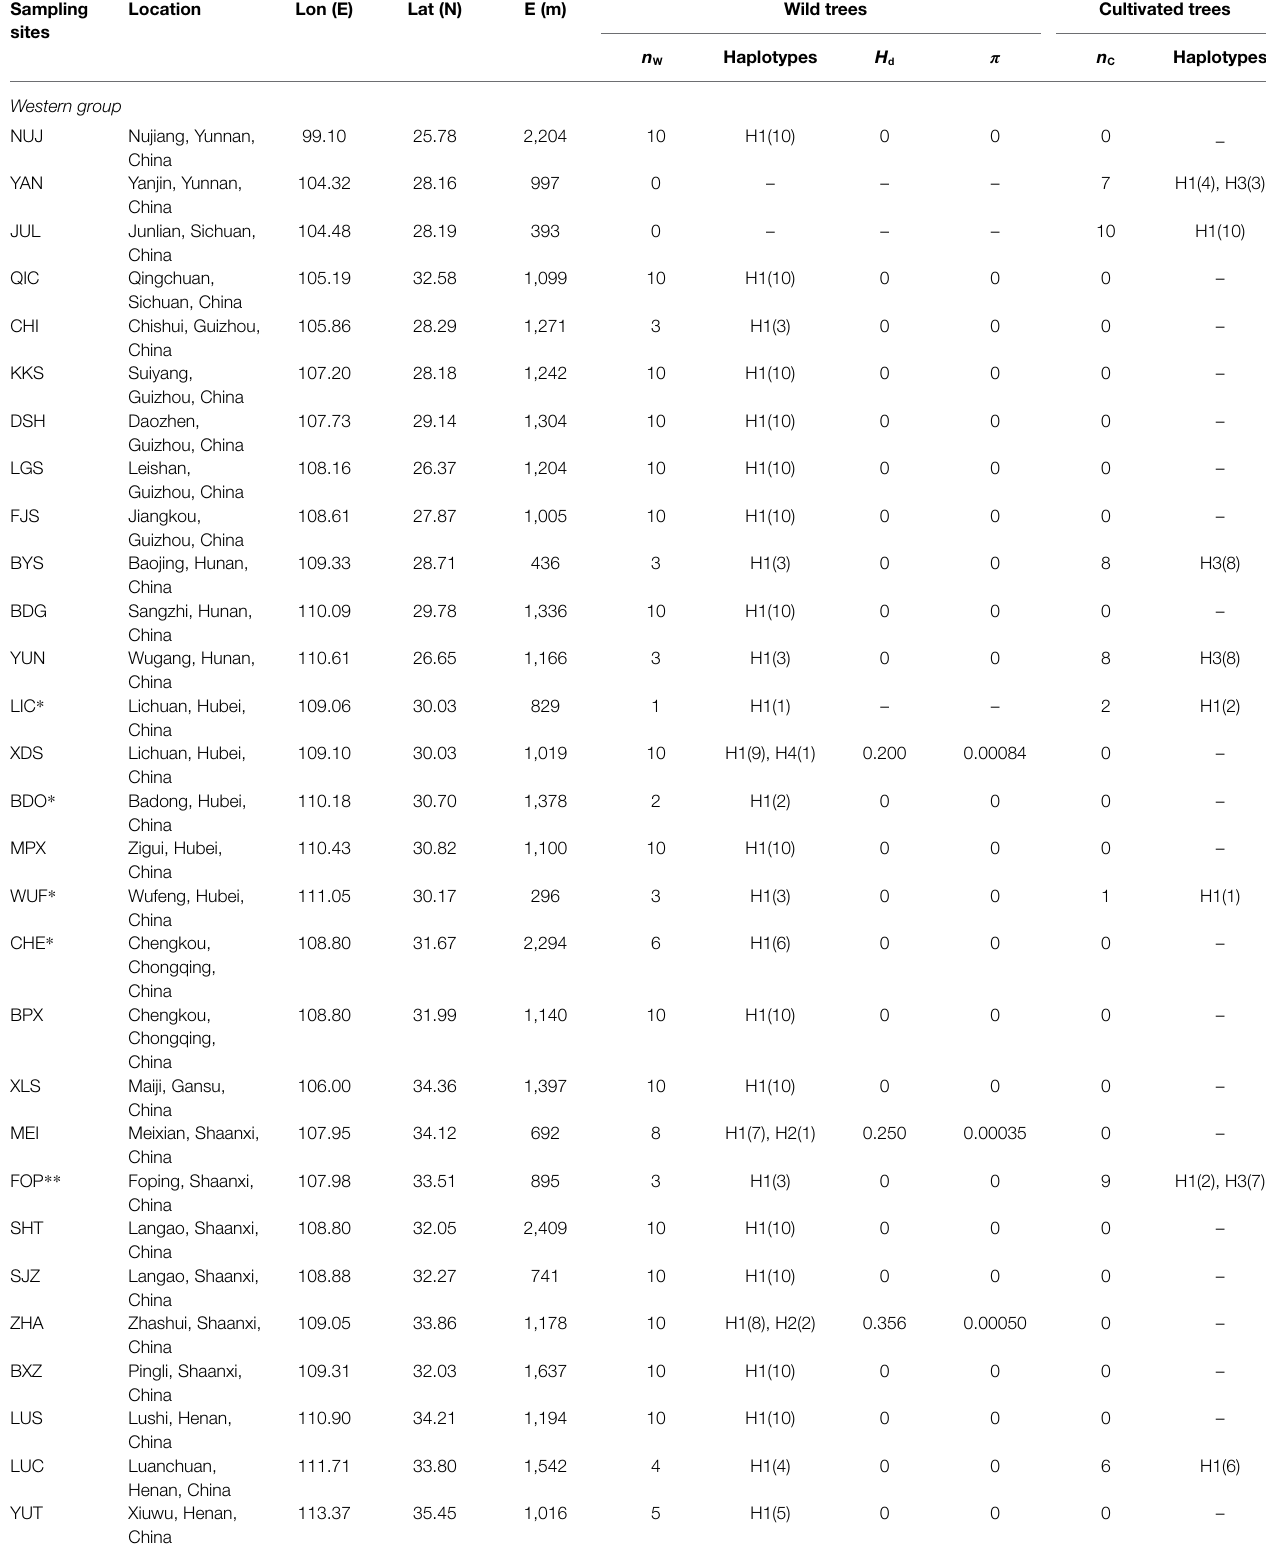
TABLE 1 | Locations and genetic statistics of 79 sampling sites of Toxicodendron vernicifluum. Sampling sites